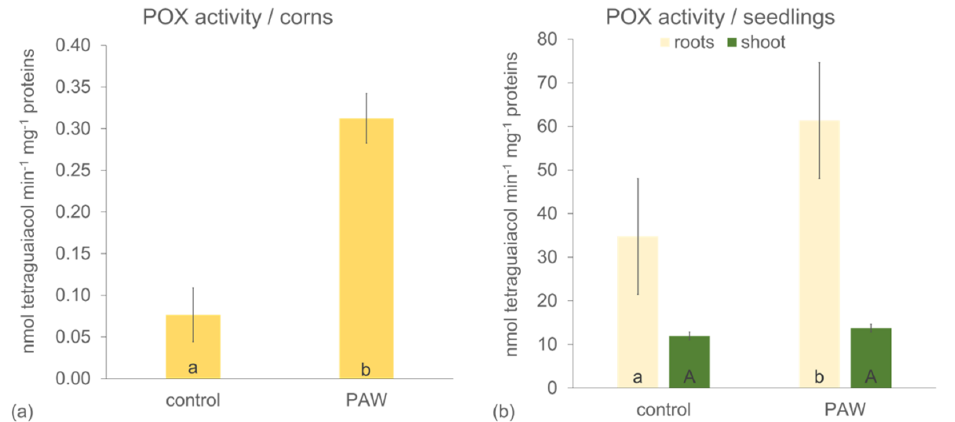
Figure 1. Activity of guaiacol peroxidase (G-POX, POX) in maize corns (hybrid Bielik) after 6 h imbibition ( a ) and in the roots and the shoot after 3 days of cultivation in the paper rolls; and ( b ) in the control (tap water) or treated with PAW. Values are means of four replicates ± SD. Different letters denote a significant difference between the treatments. The growth of primary seminal root and the shoot after the treatment with PAW im- proved in comparison with control plants (Figure 2). The increase in the PAW treatment was 13% in both roots and the shoot.